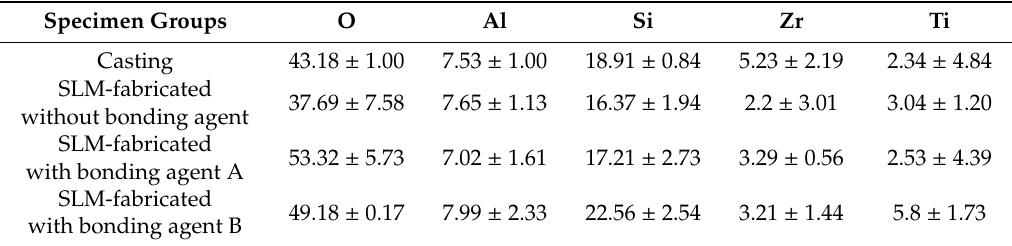
Figure 8. EDS analysis of the fractured Co-Cr and ceramic interface. ( a ) Casted group specimens; ( b ) SLM-fabricated specimens without bonding agent; ( c ) SLM-fabricated specimens with bonding agent A; ( d ) SLM-fabricated specimens with bonding agent B. Table 6. EDS analysis results for the fracture surfaces (mean ± standard deviation).